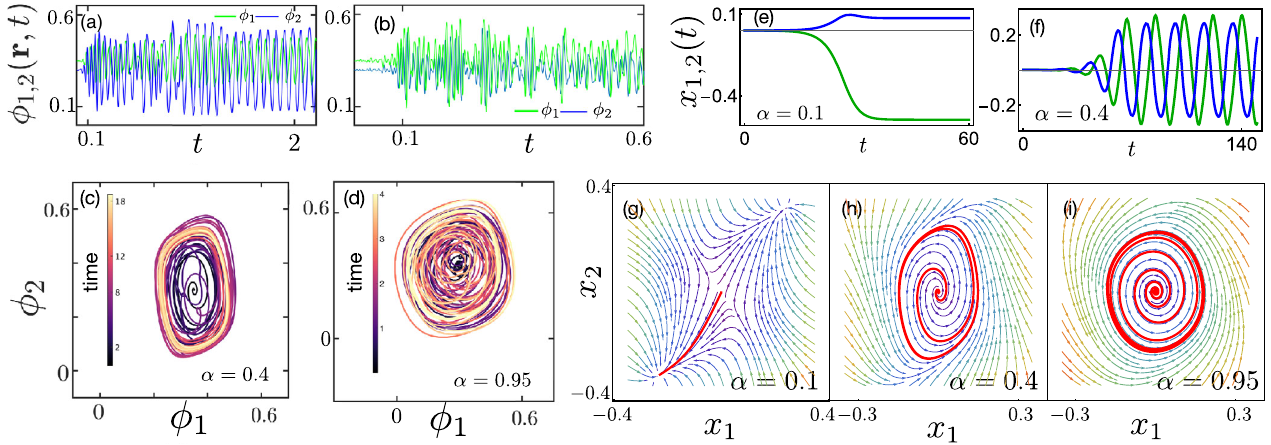
FIG. 4. Onset of instability and comparison with the minimal oscillator model described in Sec. IV B. (a,b) Temporal variation of the density fields ϕ i and (c,d) corresponding phase portraits taken at a randomly chosen point in space r for (a,c) α ¼ 0 . 4 and (b,d) α ¼ 0 . 95 . Temporal trajectories of the underlying nonconserved dynamical system are shown in panels (e,f) for α ¼ 0 . 1 and 0.4, with initial conditions very close to (0,0). Phase portraits for α ¼ 0 . 1 , 0.4, and 0.95 are shown in panels (g) – (i), with a trajectory originating from (0,0) highlighted in red. (g) At low α , there are two stable points. (h,i) Spiral trajectories and a limit cycle arising for large enough α . Note the similarity in the form of the limit cycles in panels (c) and (h), and (d) and (i). Parameters for the free energy are as in Fig. 1. The system size of 201 × 201 is used in all of the simulations here, with a time step of 10 − 4